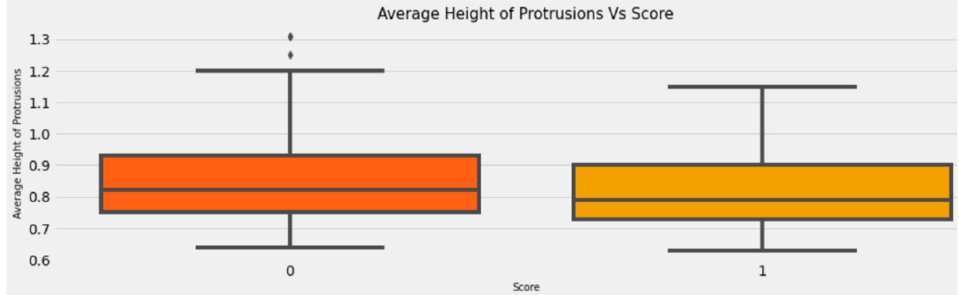
Figure 10. Effect of average height of protrusions on the target class.